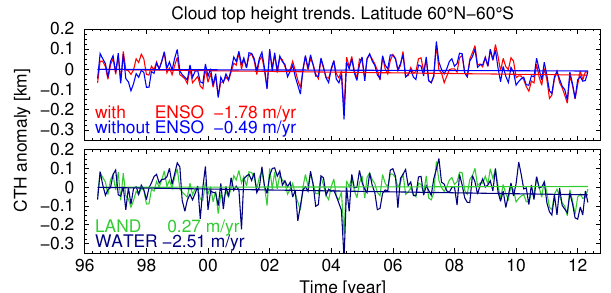
Figure 11. (Upper plot) Global trend β in CTH anomalies in the latitude belt ± 60 ◦ , with (red line) and without (blue line) ENSO region. (Lower plot) The time series are broken up for underlying surface. Abundances of land and water masses between 60 ◦ N and 60 ◦ S are 0.264 and 0.736,